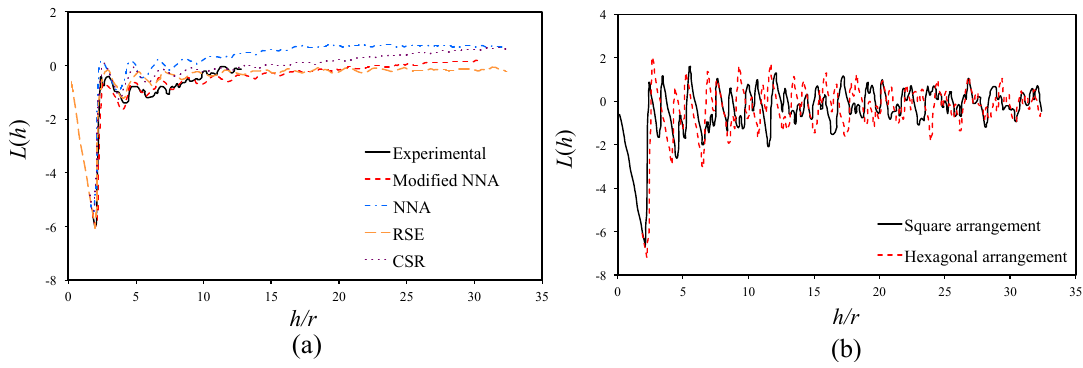
Figure 6. ( a ) L(h) for experimental characterized and numerical generated RVE; and ( b ) L(h) for periodic RVE of square arrangement and hexagonal arrangement.